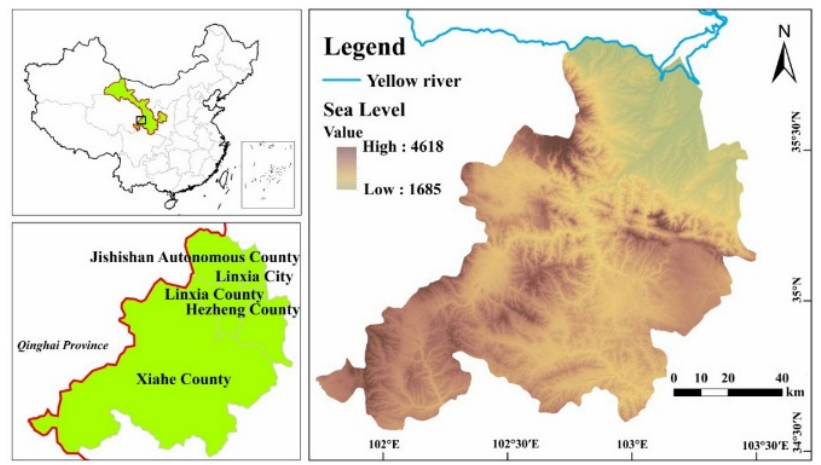
Figure 1. Location of the study region.